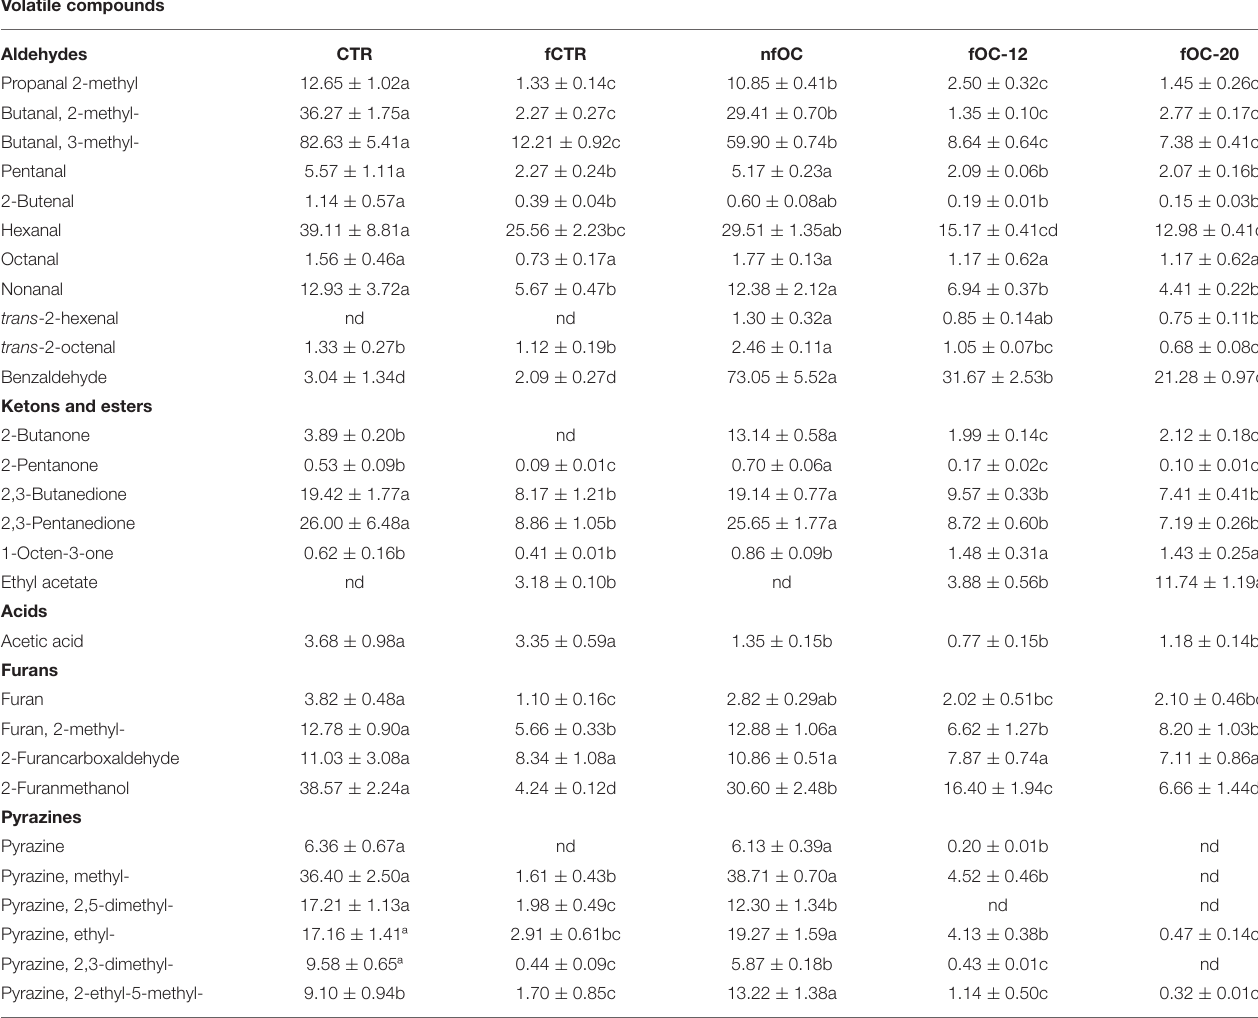
TABLE 5 | Volatile compounds ( µ g g − 1 ) detected in the different samples of breadsticks. Volatile